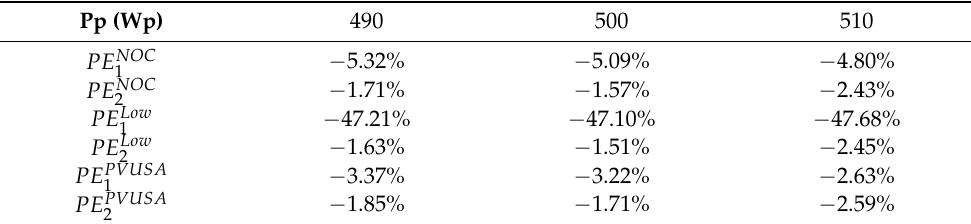
Table 5. PE for thin-film bifacial PV modules, under Normal Operating Conditions (NOCs), Low- Irradiance Conditions ( Low ), and PVUSA conditions ( PVUSA ). PE 1 relates to the error between PDC 1 and P , and PE 2 relates to the error between PDC 2 and PDC 1 ; CEC database validation.